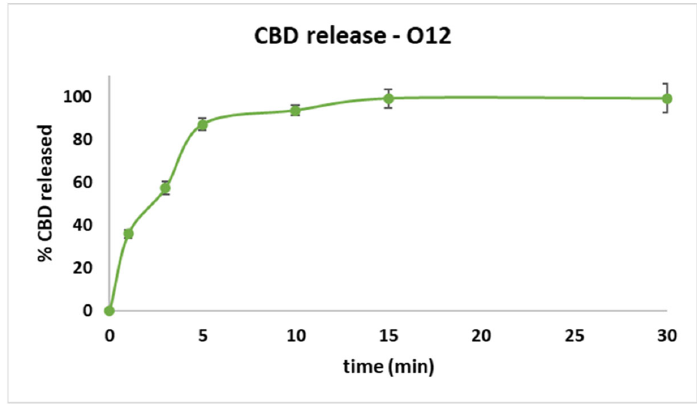
Figure 4. The amount of API released for O12.